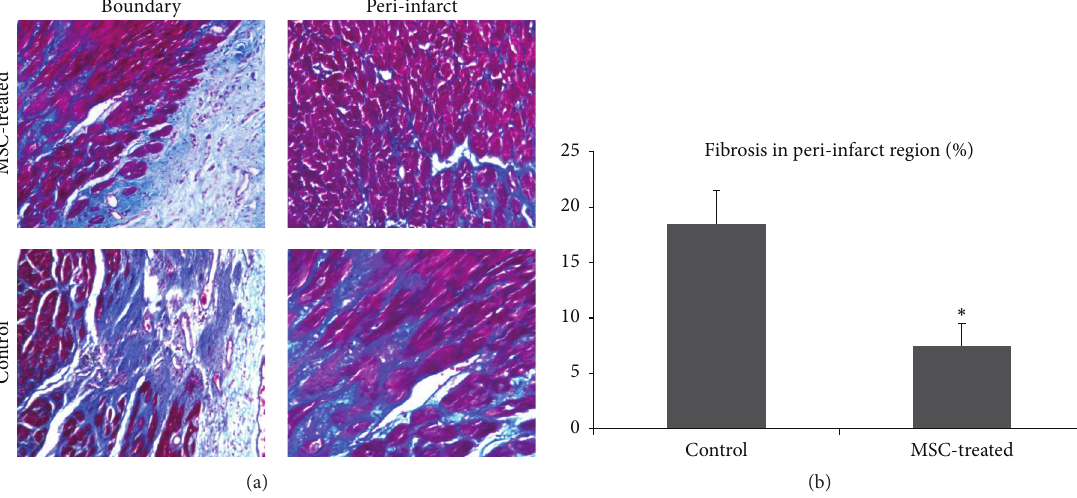
Figure 5: Myocardial fibrosis in peri-infarct area 4 weeks after transplantation. (a) Masson staining showed that, in control hearts, the border of myocardial infarction was more irregular and the fibrosis was more pronounced (original magnification × 200). (b) Quantification of fibrosis. 𝑁 = 3 for each group, ∗ 𝑝 < 0.05 versus